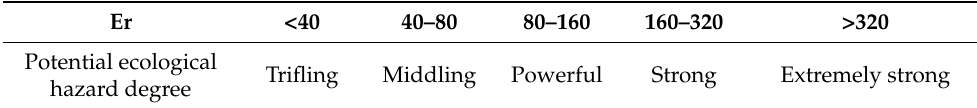
Table 1. Potential ecological risk analysis